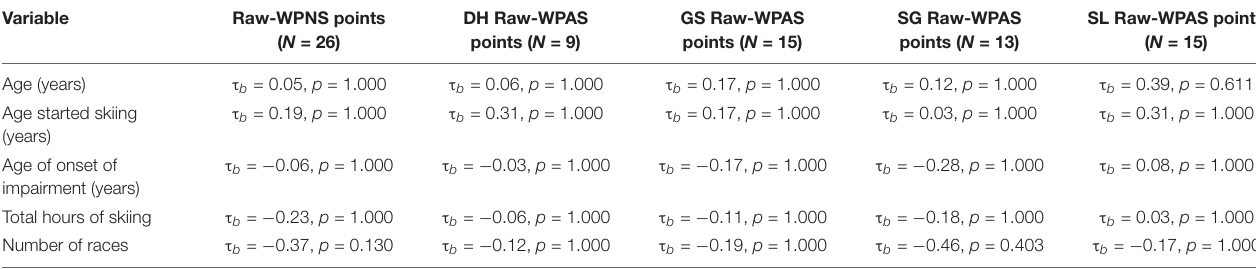
TABLE 7 | Summary of correlations of non-vision variables with skiing performances.